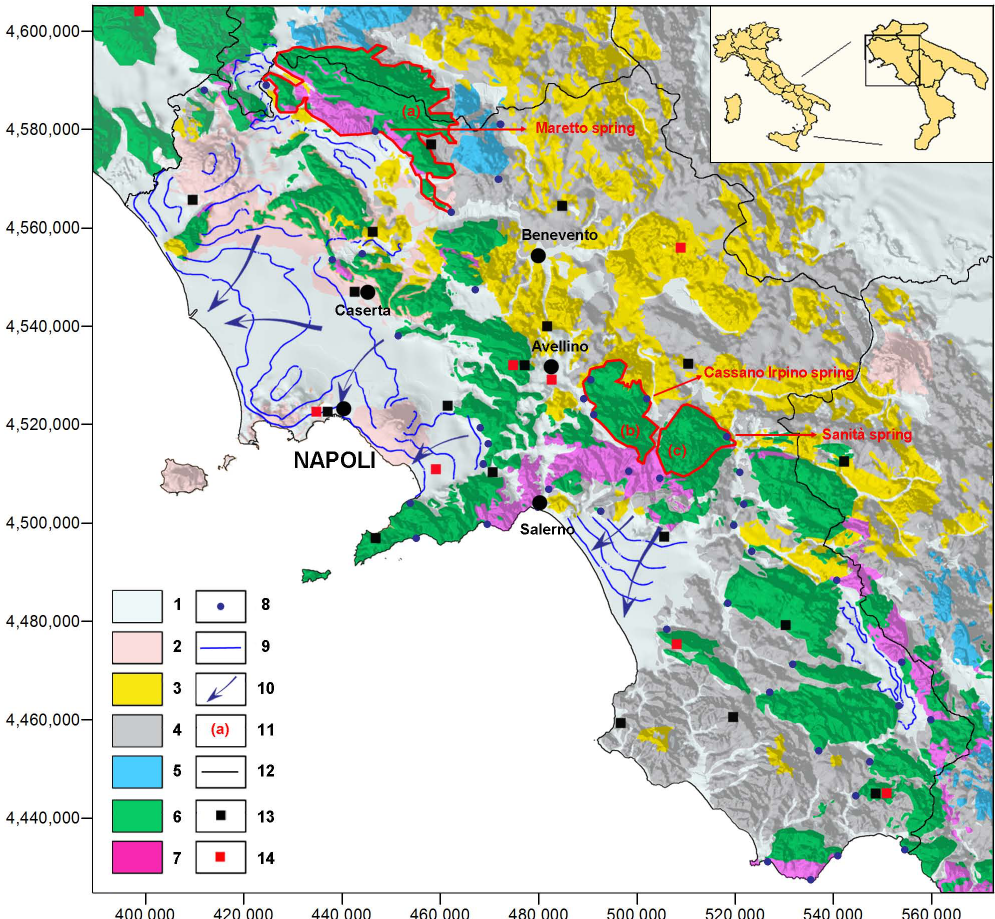
Fig. 1. Hydrogeological map of the Campania region. Hydrostratigraphic units and key to symbols: (1) alluvial and epiclastic units (Quater- nary); (2) volcanic units (Pliocene-Quaternary); (3) late orogenic molasses and terrigenous units (Upper Miocene-Pliocene); (4) pre-orogenic and syn-orogenic terrigenous units of inner and thrust-top basins series (Cretaceous-Upper Miocene); (5) siliceous-marly units of outer basin series (Trias-Paleogene); (6) limestone and dolomitic limestone units of carbonate platform series (Jurassic-Paleogene); (7) dolomitic units of carbonate platform series (Trias-Jurassic); (8) main basal springs of carbonate karst aquifers; (9) groundwater head contour lines in alluvial and volcanic aquifers; (10) main preferential drainage axes of groundwater flow in alluvial aquifers; (11) identification of the carbonate karst aquifers analysed: (a) Matese Mount; (b) Terminio Mount; (c) Cervialto Mount; (12) regional boundary; (13) rain gauge stations; (14) air temperature monitoring